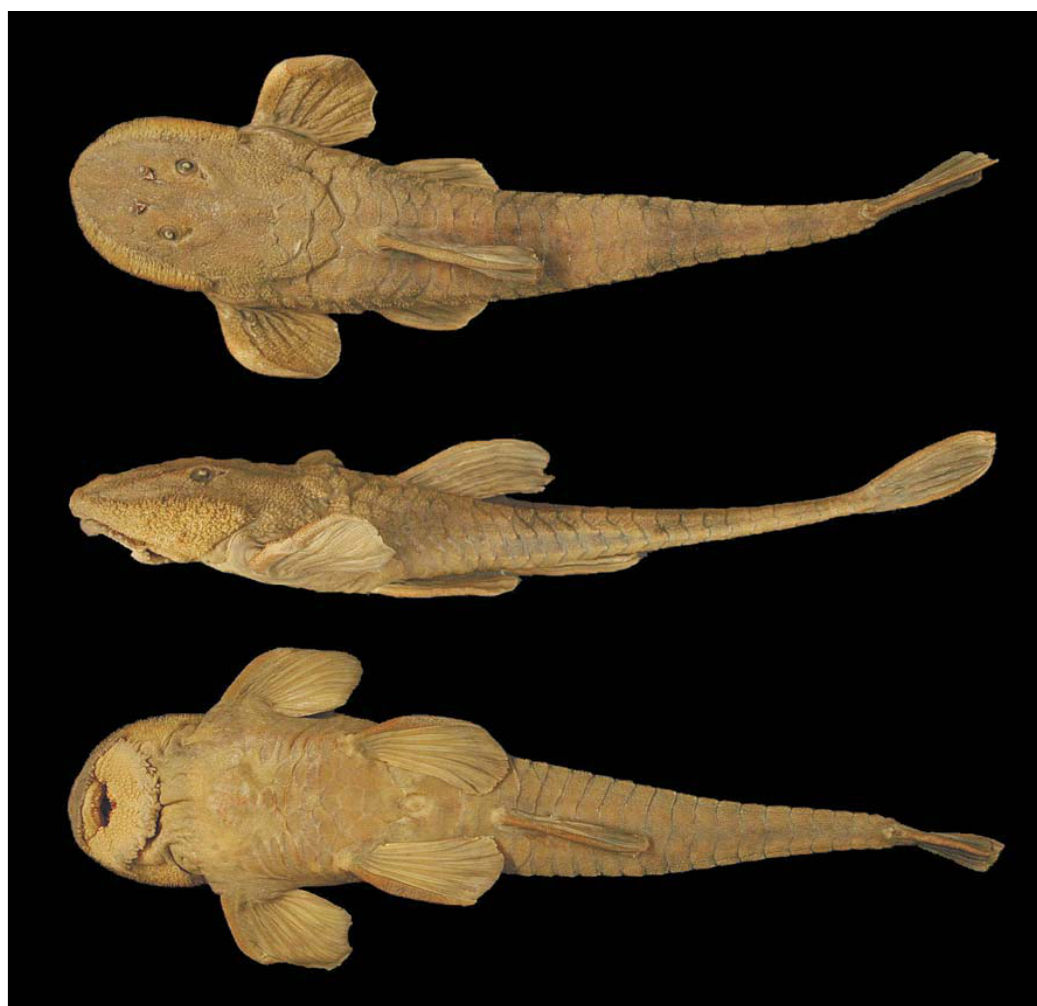
Fig. 6. Rineloricaria latirostris , lectotype, BMNH 1899.12.18.6, 228 mm SL (photo by C. Zawadzki); dorsal, lateral and ventral